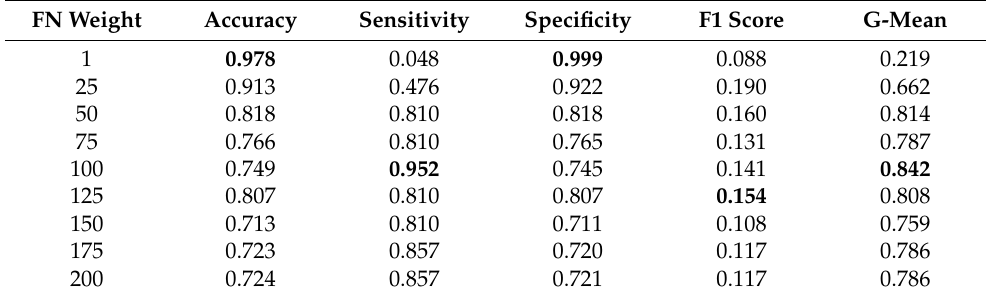
Table 2. The effects of the weight of false negative predictions on all metrics using the PSO (for the dataset of Spanish companies). The best result for each metric is marked in boldface.